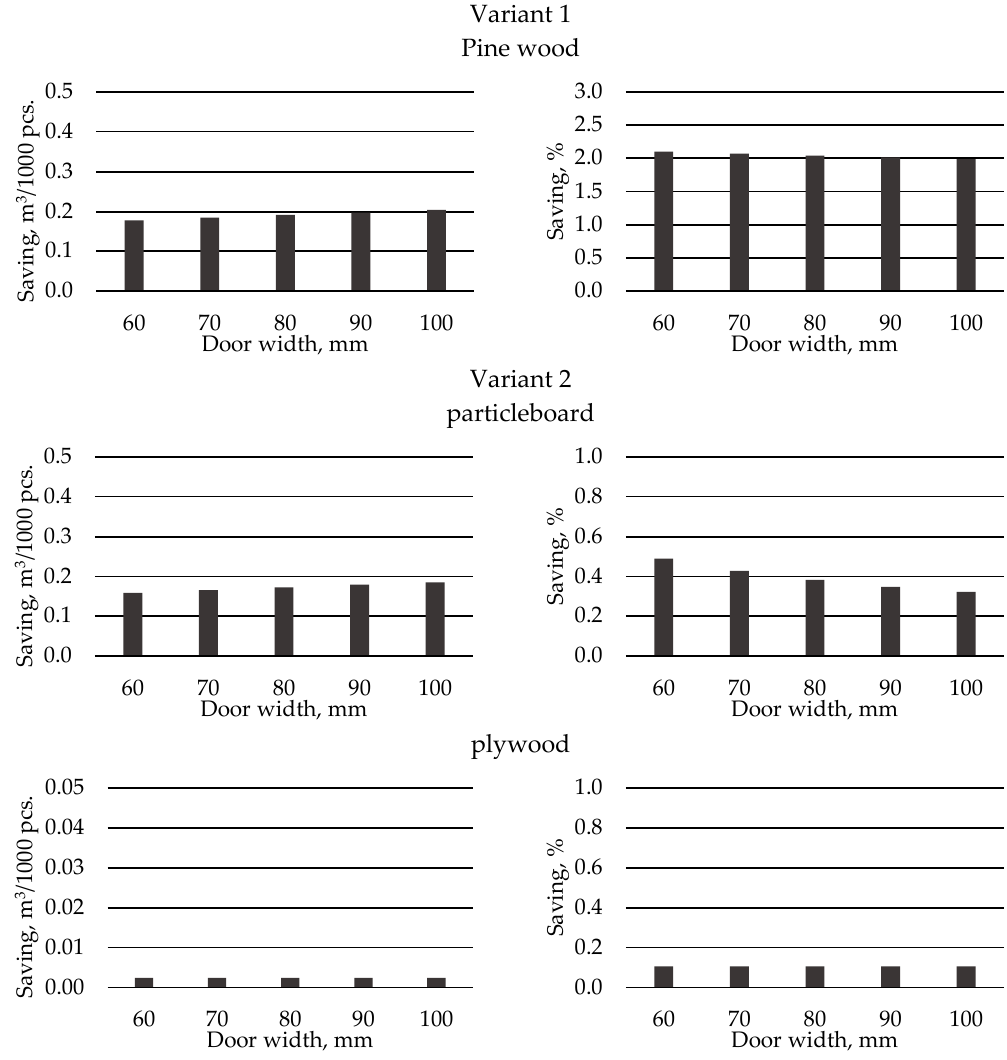
Figure 8. Material savings obtained by reducing the machining allowance in construction 2.